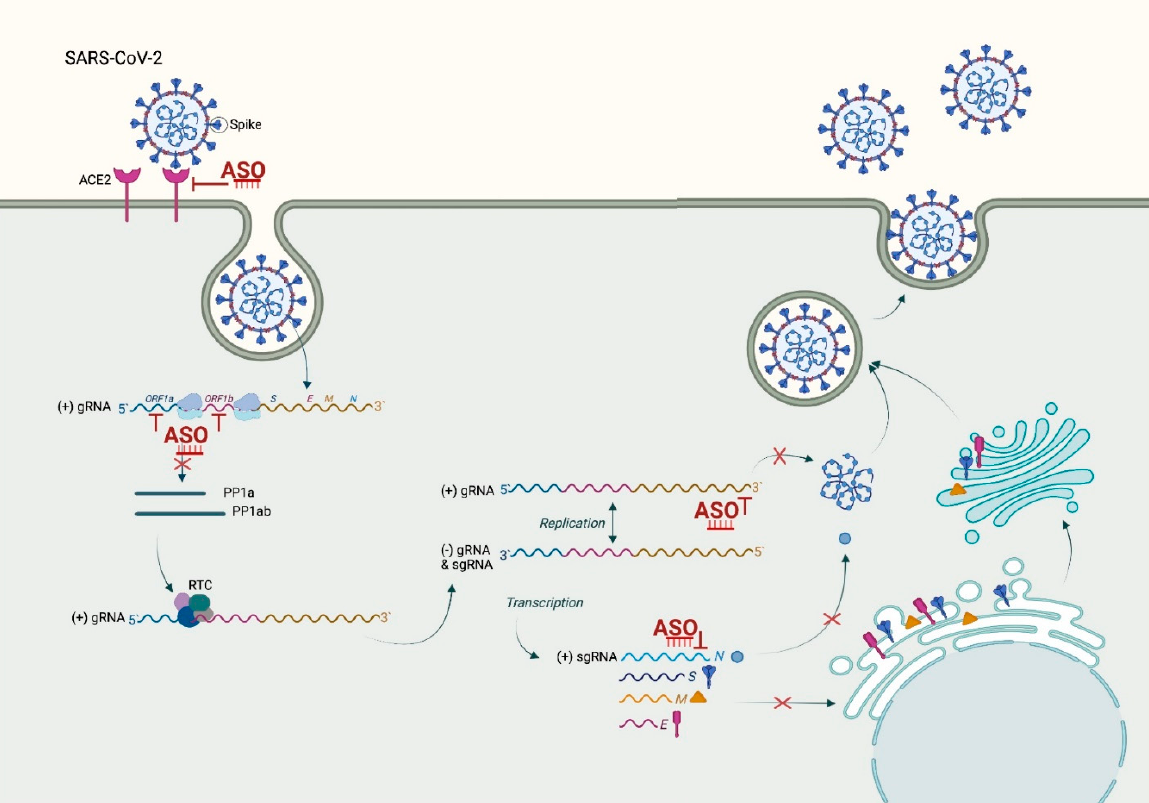
Figure 2. Possible therapeutic use of ASOs in the SARS-CoV-2 infection. ASOs can be used to prevent virus recognition though ACE-2 receptor and prevent SARS-CoV-2 from entering into the cell host. Moreover, ASOs can be used to stop the viral life cycle at different steps, providing important therapeutic entries. In addition, targeting different phases of the viral life can allow combinational therapy to produce a stronger inhibition. This figure was created with BioRender.com; accessed date 12 January 2022.